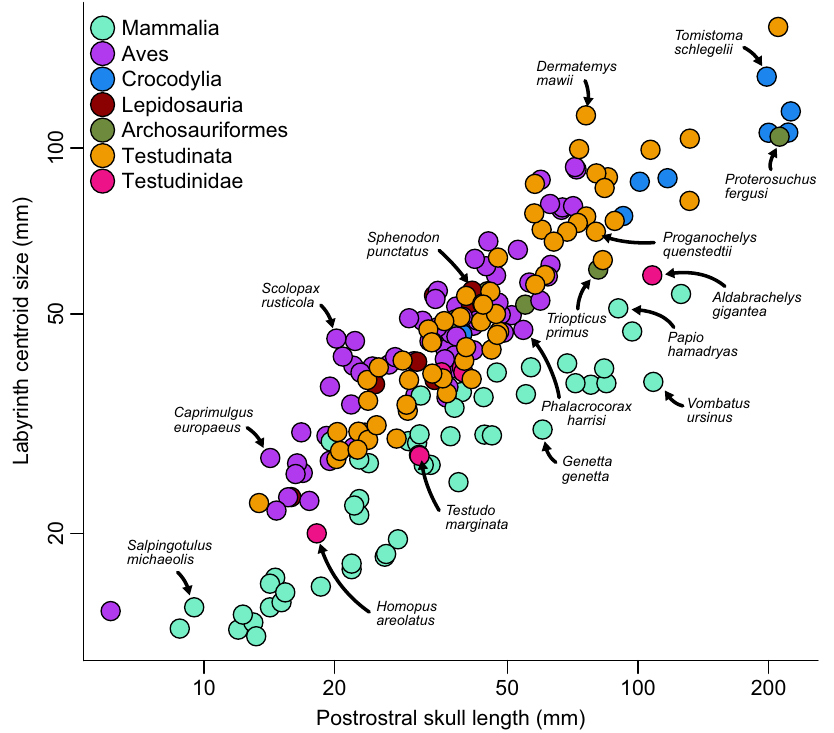
Fig.4|Relativelabyrinthsizesintetrapods. Labyrinthcentroidsizedataplottedagainstpostrostralskulllengths.Aversionofthis fi gurewhichidenti fi eseachspeciesis presented in Supplementary Fig. 10. Source data are provided with this